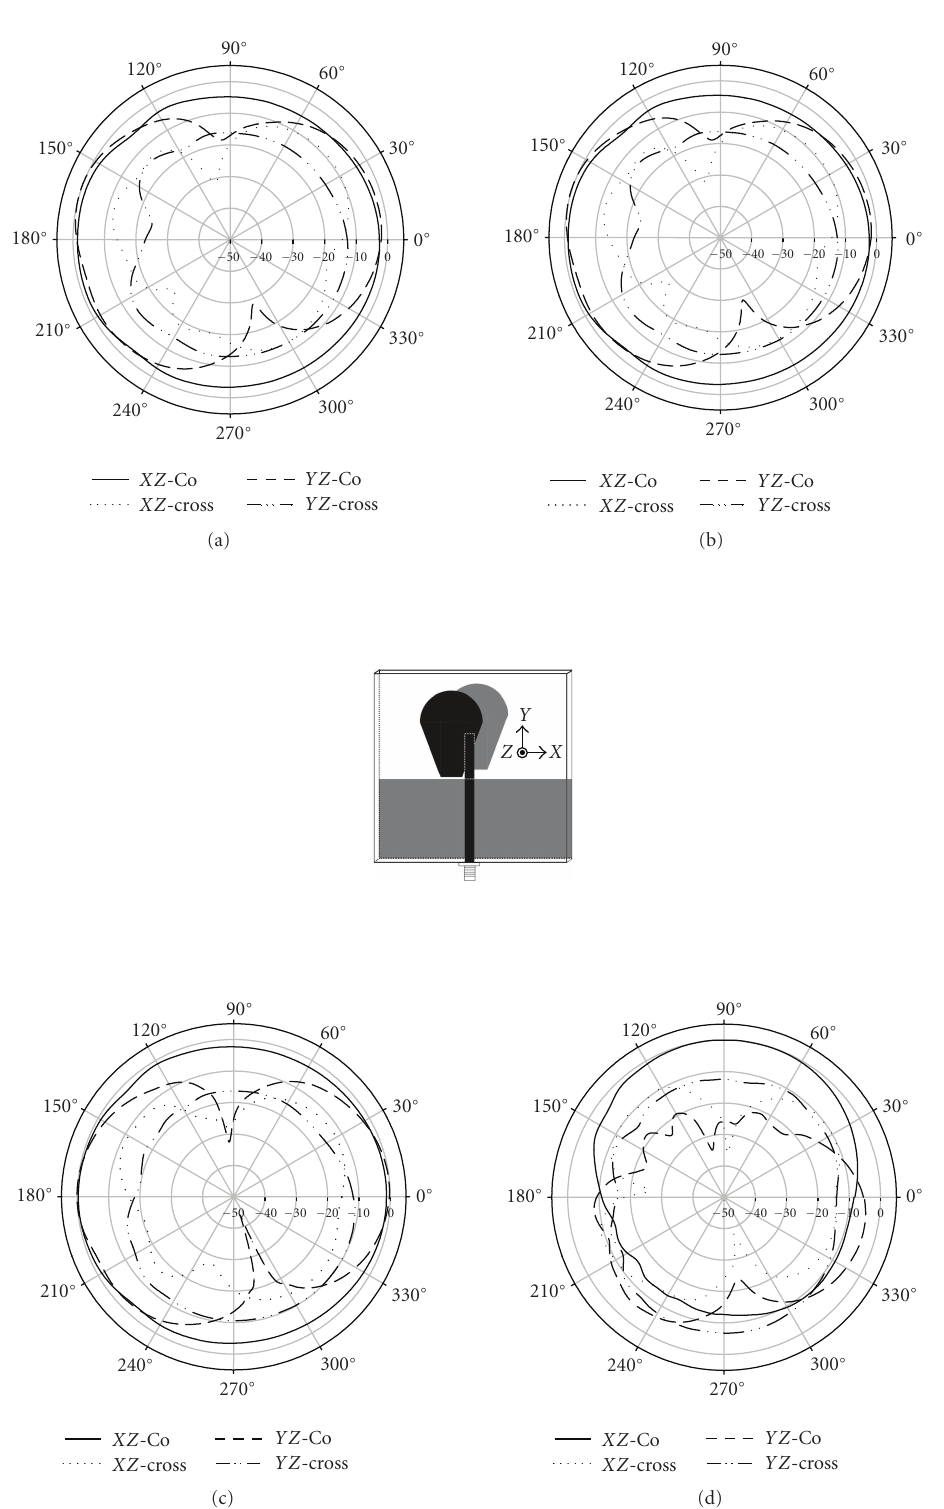
Figure 8: Measured radiation patterns of the proposed antenna (a) 1.7 GHz, (b) 1.8GHz, (c) 2.4GHz, (d) 4.9 GHz [ L = 67, W G = 67, L W W . 5, L R S . 3, S . 5, S S . 25, h = 1 . 6 (units in mm), ε L G = 29, M = 15, M = 3, R = 7 R = 19, R = 11, H 1 = 0 L 1 = 6 H 2 = 3, L 2 = 5